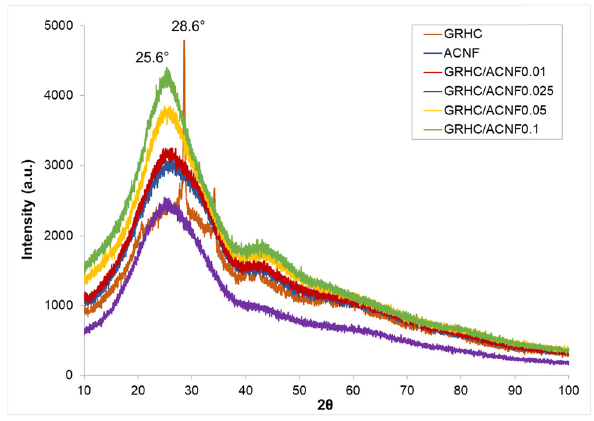
Figure 2: XRD spectra of GRHC, pristine, and composite ACNFs with di ff erent loadings of